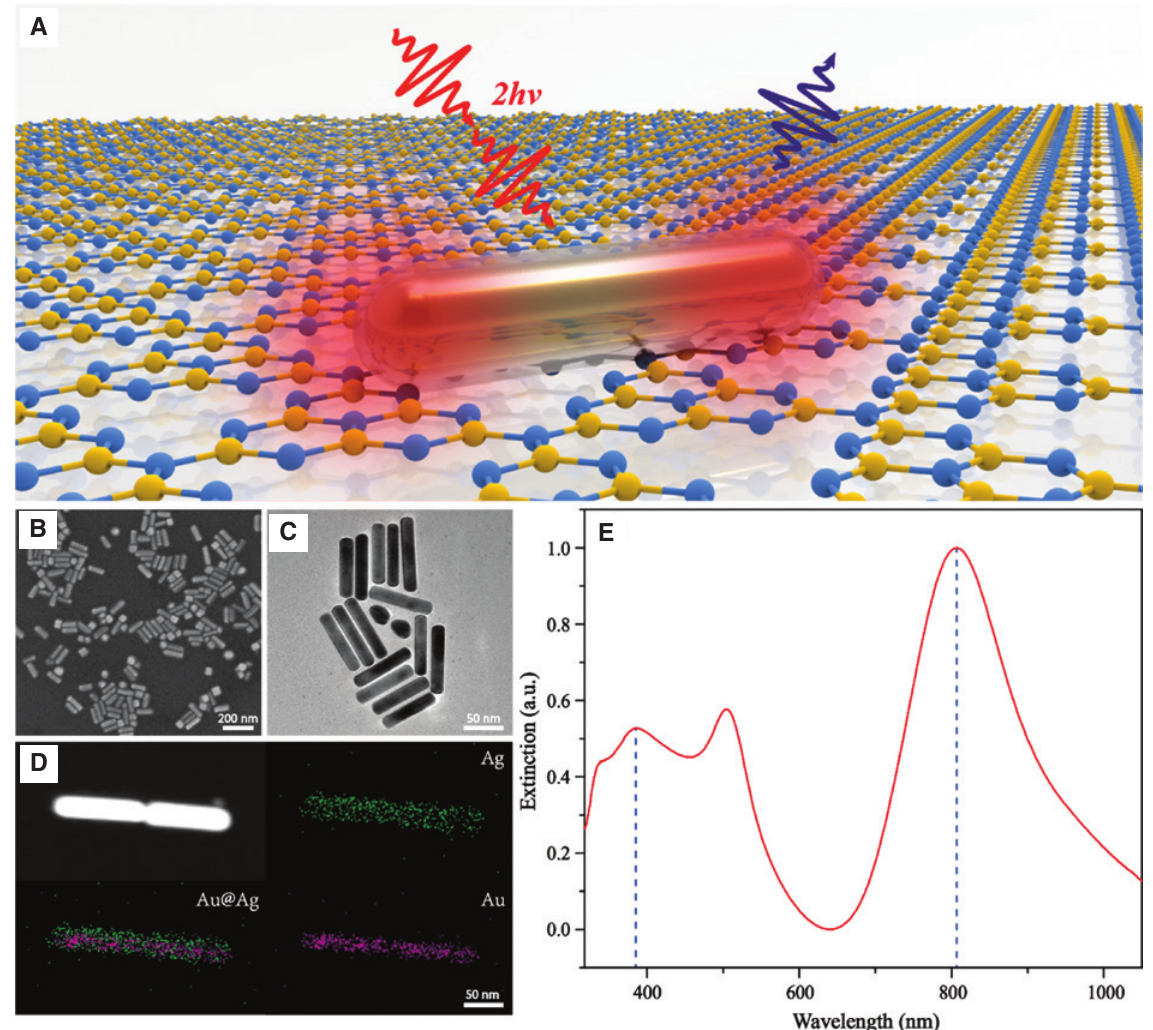
Figure 1: Characterization and optical properties of Au@Ag nanorods. (A) Plasmon-enhanced nonlinear optical microscopy of g-C